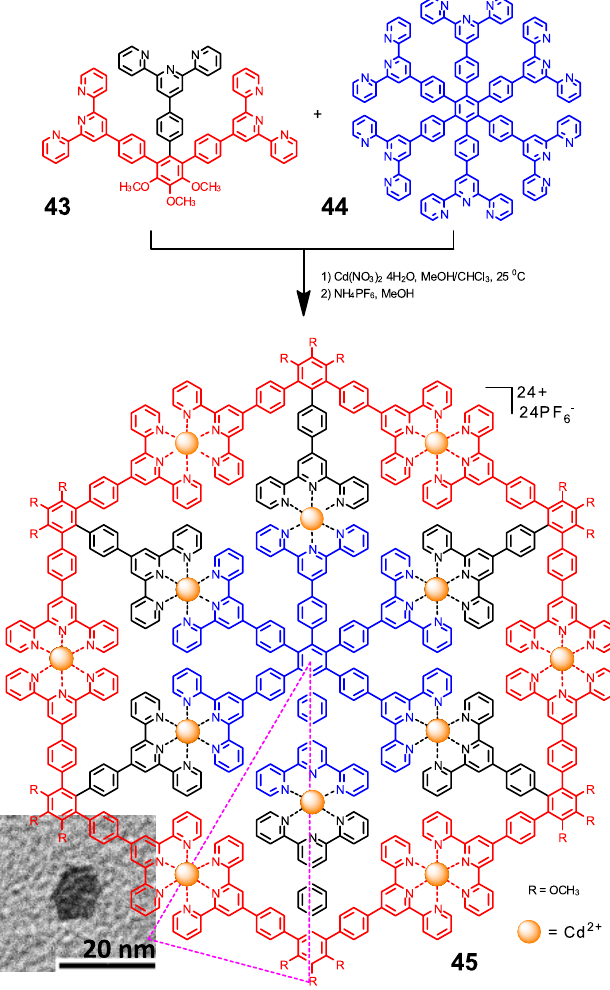
symmetric, spoked wheel FIGURE 19 – Self-assembly of a D 6h and its TEM image. The dotted line triangle represents the smallest repeating subunit of 45 [Wang, J.-L.; Li, X.; Lu, X.; Hsieh, I.-F.; Cao, Y.; Moorefield, C. N.; Wesdemiotis, C.; Cheng, S. Z. D.; Newkome, G. R. J. Am. Chem. Soc. , v.133, p.11450- 11453, 2011. – Reproduced by permission of The American Chemical